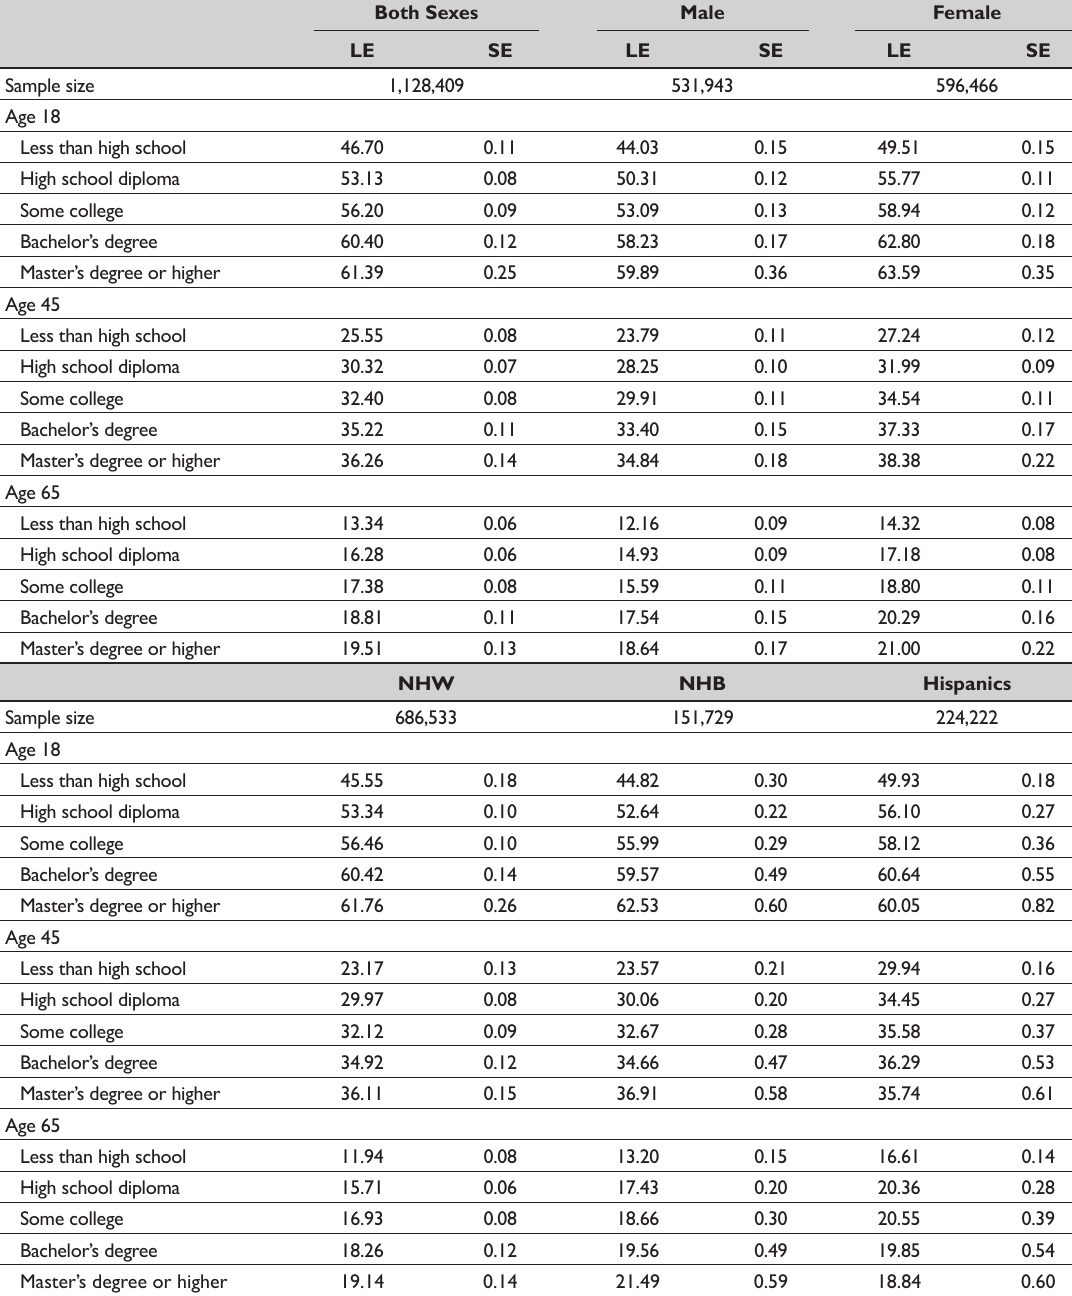
Table 1: Estimated life expectancies at selected ages at baseline by education, United States, 1997-2014 Both Sexes Male Female